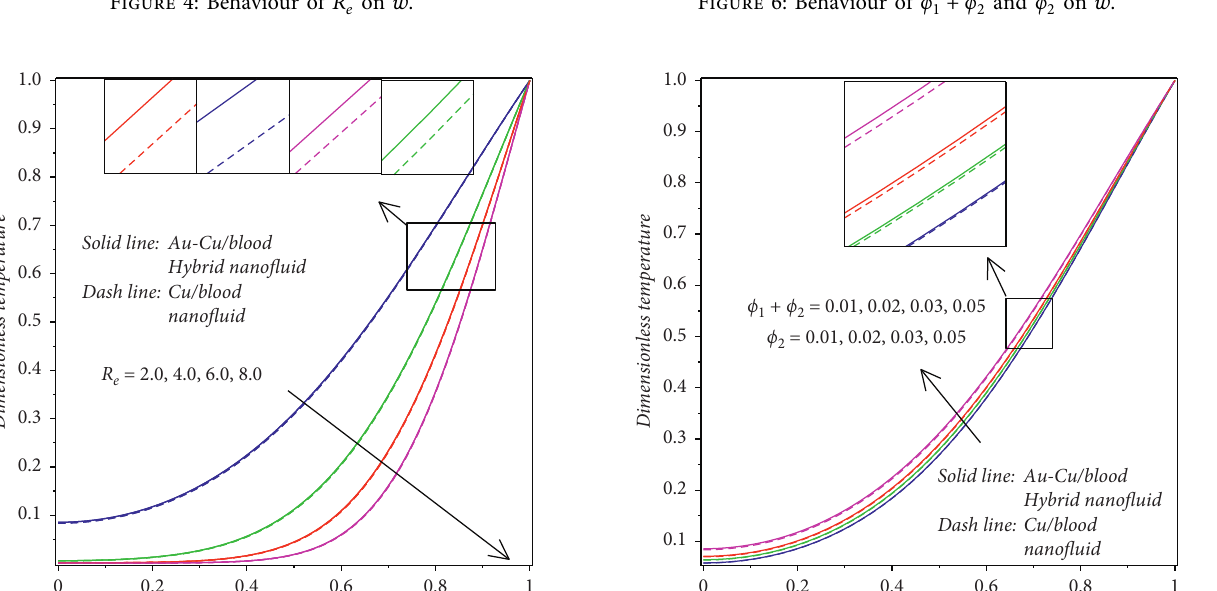
Figure 4: Behaviour of R